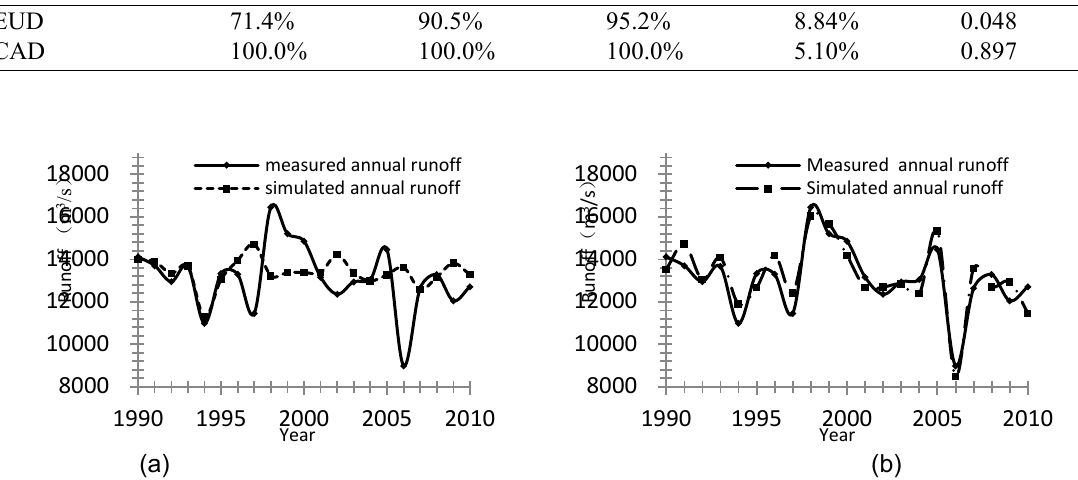
Table 1 Prediction performance based on CAD and EUD. Similarity estimation